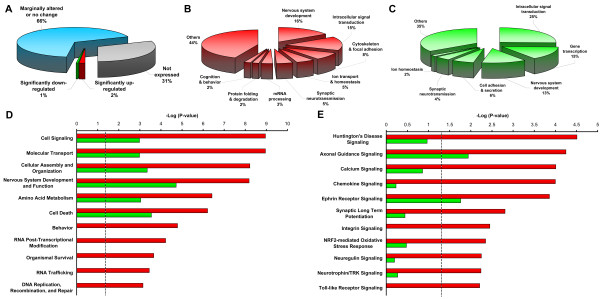
Enrichment analysis of functional groups of up- and down-regulated genes associated with chronic glutamate hyperactivity. (A) Approximately 2% of the over 39,000 gene transcripts surveyed by Affymetrix Mouse Genome 430 2.0 Array were identified to be significantly up-regulated, and 1% to be down-regulated, with an FDR of 0.9%. (B, C) Gene Ontology (GO) analysis of up- (B) and down-regulated (C) biological processes associated with chronic glutamate hyperactivity. This analysis was conducted with GO-elite using hypergeometric distribution. A Z score > 1.96 or < -1.96 and a permute P value < 0.05, were considered to be statistically significant. (D, E) Comparative analyses of over-represented bio-functions and canonical pathways, respectively, in up- and down-regulated genes using Ingenuity Pathway Analysis (IPA). Significance calculated by IPA was plotted as -log P value and the dashed line corresponds to the threshold P = 0.05.